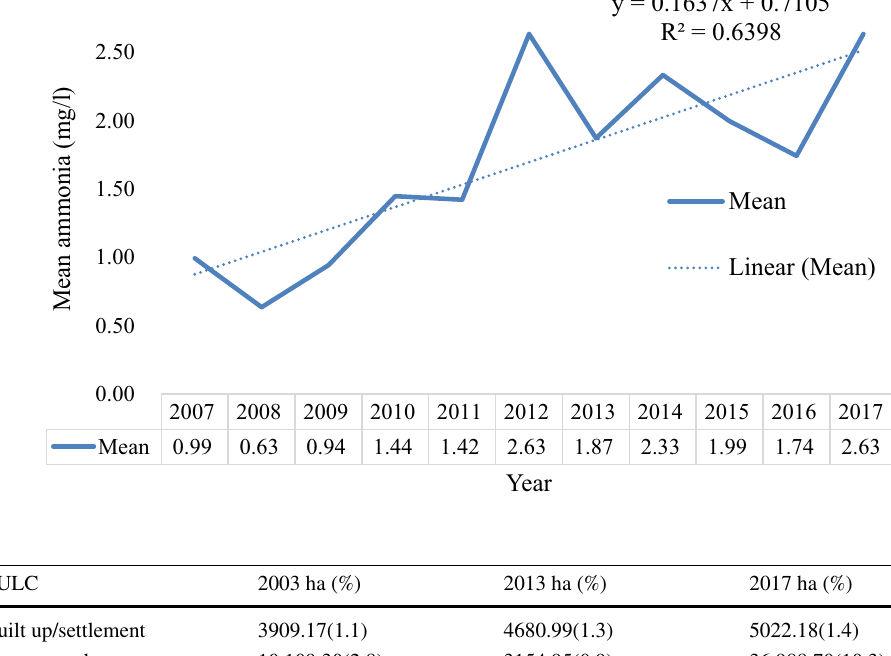
Fig. 3 Annual temporal varia- tion of ammonia in the Nawuni Catchment